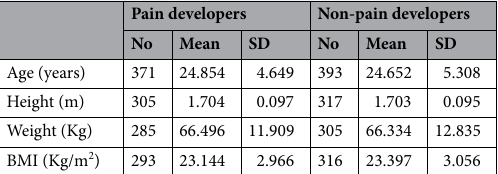
Table 1. Demographics of PDs and NPDs.